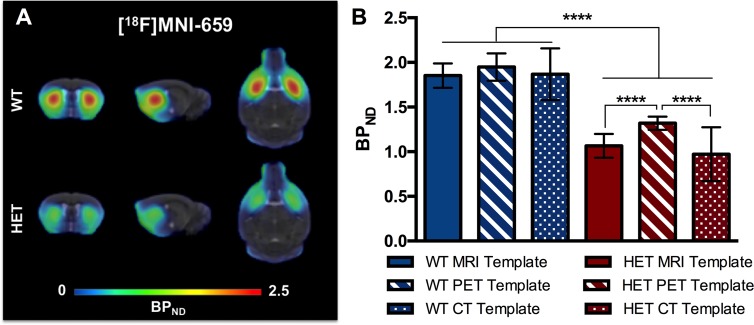
[18F]MNI-659 PET quantification.(A) Average [18F]MNI-659 BPND images of 6 months old WT and HET Q175 mice following MRI template-based spatial normalization. PET images are overlaid onto the genotype-specific MRI templates. (B) Striatal [18F]MNI-659 BPND values for HET (n = 15) and WT littermates (n = 16) Q175 mice of 6 months of age. All spatial normalization approaches (MRI, PET, and CT template-based) showed a significantly reduced [18F]MNI-659 binding for HET Q175 mice compared to WT littermates (p < 0.0001). In addition, a significant difference between the MRI- and CT-based approaches was found in HET mice when compared to the PET-based approach (p < 0.0001). Repeated-measurements ANOVA including Bonferroni correction for multiple comparison. ****p < 0.0001. WT = wild-type, HET = heterozygous.